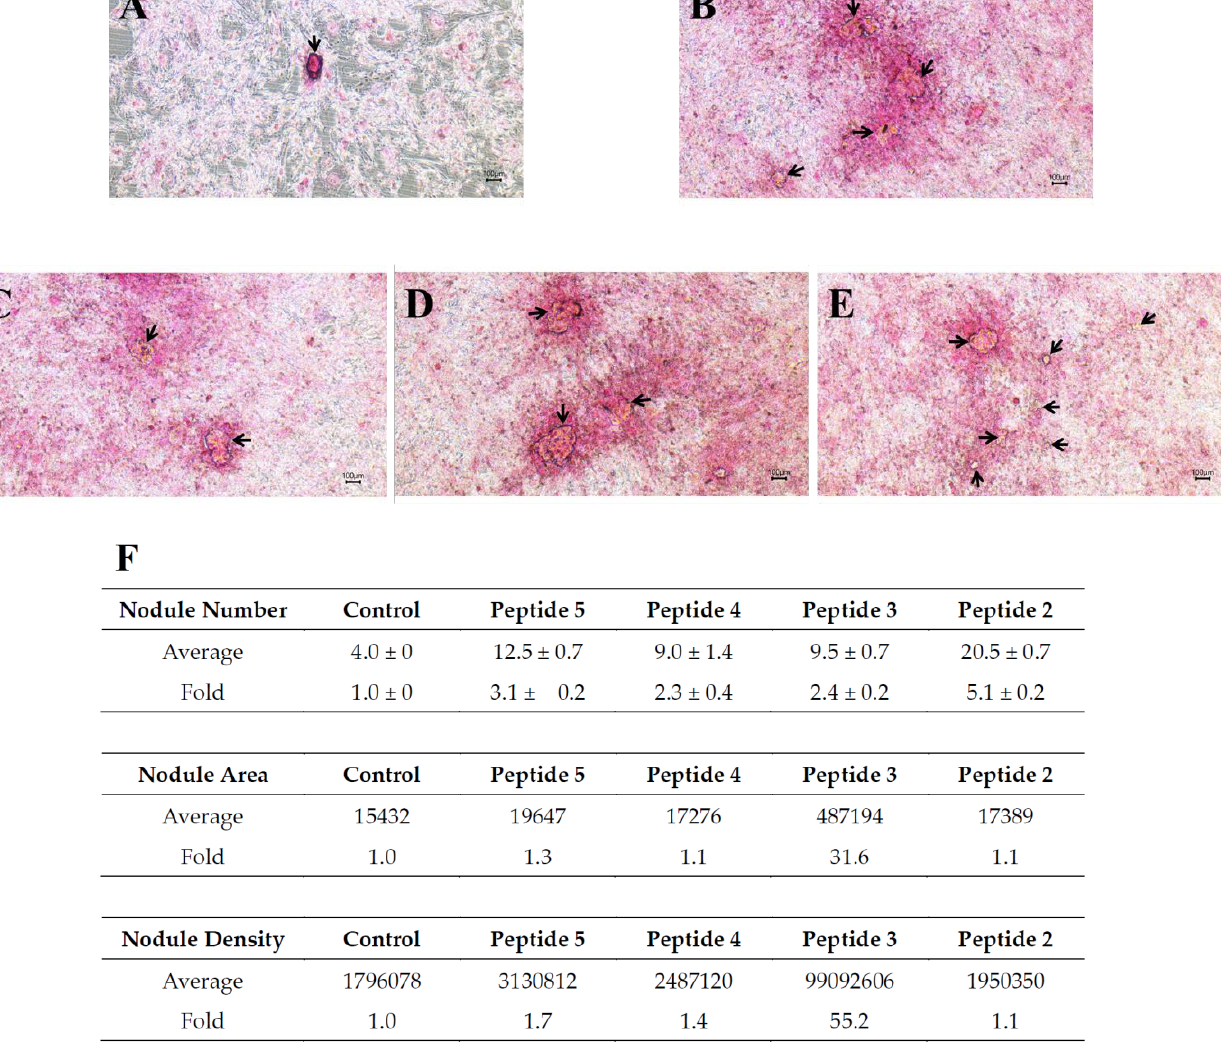
Figure 6. Representative images of Von Kossa staining showing mineralization ability on osteoblast hFOB1.1 cells after the treatment with the synthetic peptides. ( A ): Control, ( B ): peptide 5, ( C ): peptide 4, ( D ): peptide 3, ( E ): peptide 2. Black arrows show mineralized nodules (light microscopy, 40×), ( F ): quantitative analysis of mineralized bone nodule formation using image analysis software. The units for nodule area are pixels and units for nodule density are in arbitrary units (AU). Average number of nodules, average nodule area, and average nodule density were shown.